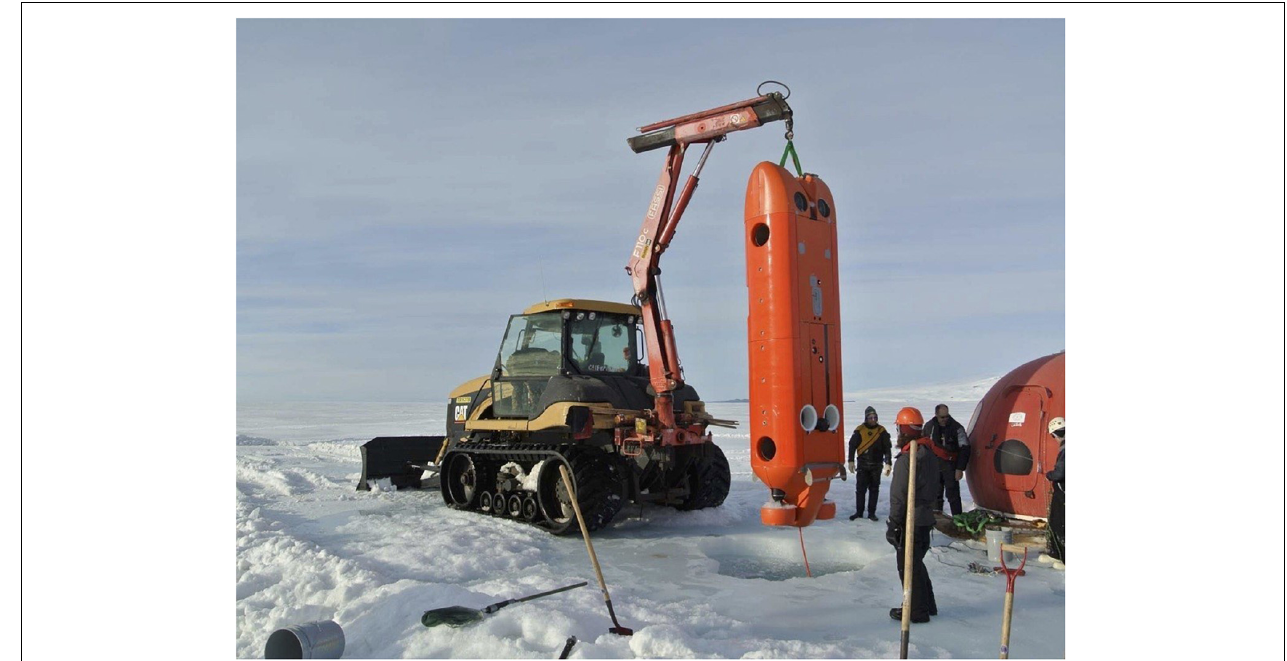
FIGURE 4 | Stone Aerospace’s ARTEMIS vehicle being launched into the Antarctic ocean through a drilled